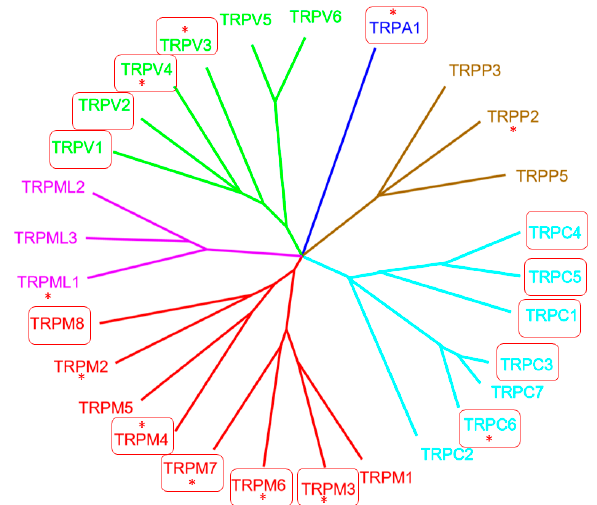
Figure 1. Phylogenetic tree of the transient receptor potential (TRP) superfamily in vertebrates. Boxed TRP channels are highlighted in the manuscripts of this special section. Stars (*) indicate the mutant TRP channels that cause human diseases. Picture modified from [5].